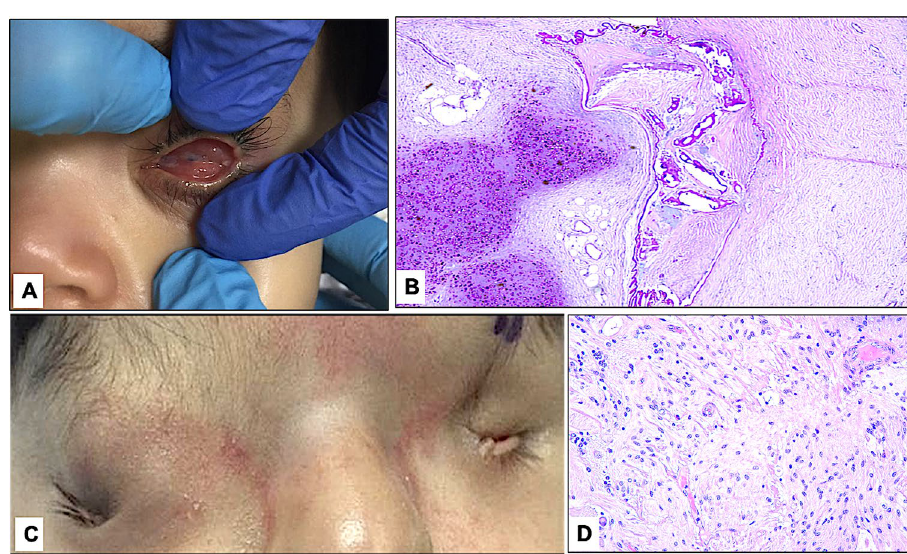
Figure 4. ( A ) The clinical appearance of the left microphthalmic globe in case 10. ( B ) The corresponding histopathological appearance of the incidental intraocular choristoma with cartilage and fat in addition to the calcified lens with wrinkled capsule in that globe (original magnification × 50, periodic acid Schiff). ( C ) The clinical appearance of a dysmorphic periocular area with bilateral cryptophthalmos and microphthalmic left eye in case 11. ( D ) The histopathological appearance of the retina in the enucleated globe with evidence of massive gliosis (original magnification × 200, hematoxylin and